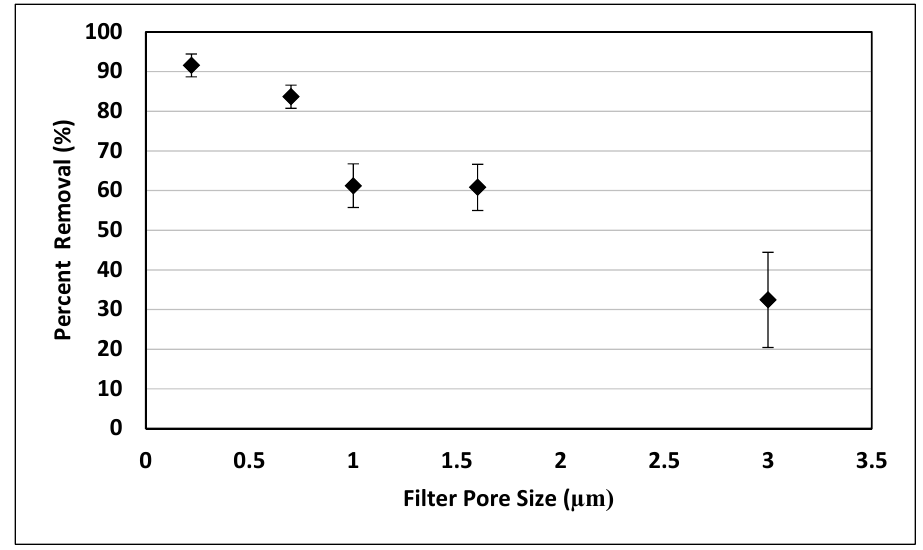
Figure 3. Percent removal of nanoplastics with filtration based on turbidity measurements.